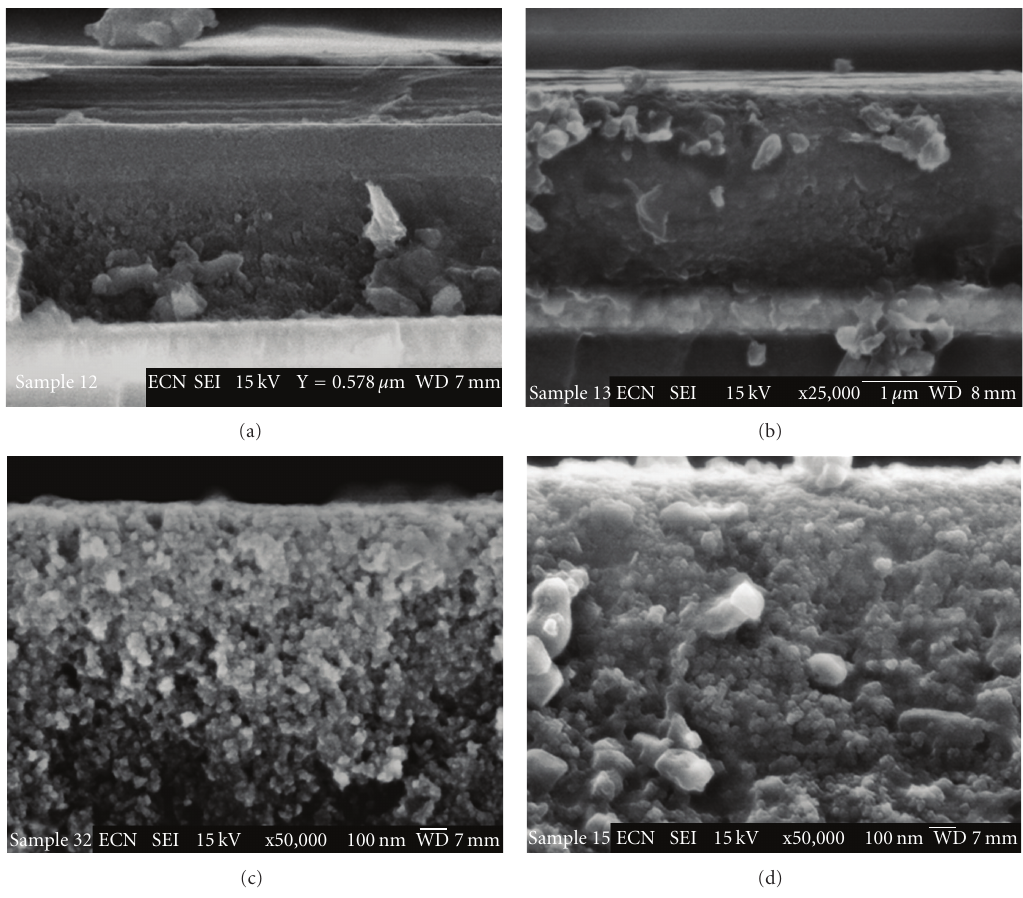
Figure 2: SEM cross-sections of ssDSCs with overlayers of (a) 580nm; (b) 190 nm (C) ∼ 10nm and (d)